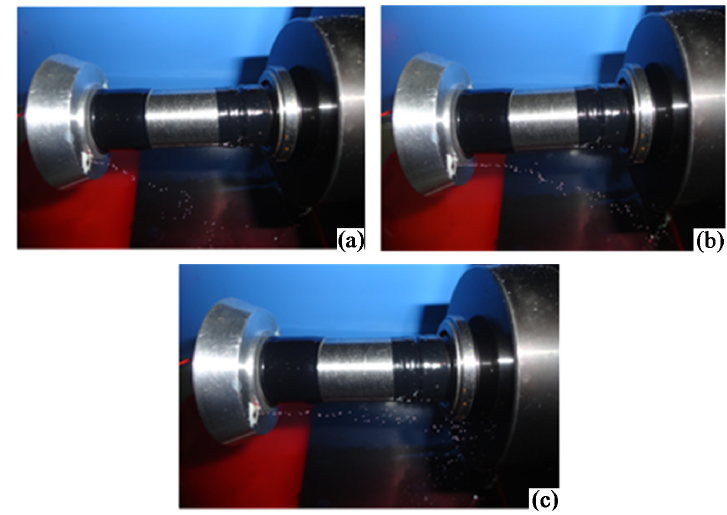
Figure 17. The injection states of the micro-jet under pulse voltages with different excitations: ( a ) the amplitude is 60 V; ( b ) the amplitude is 80 V; ( c ) the amplitude is 100 V.